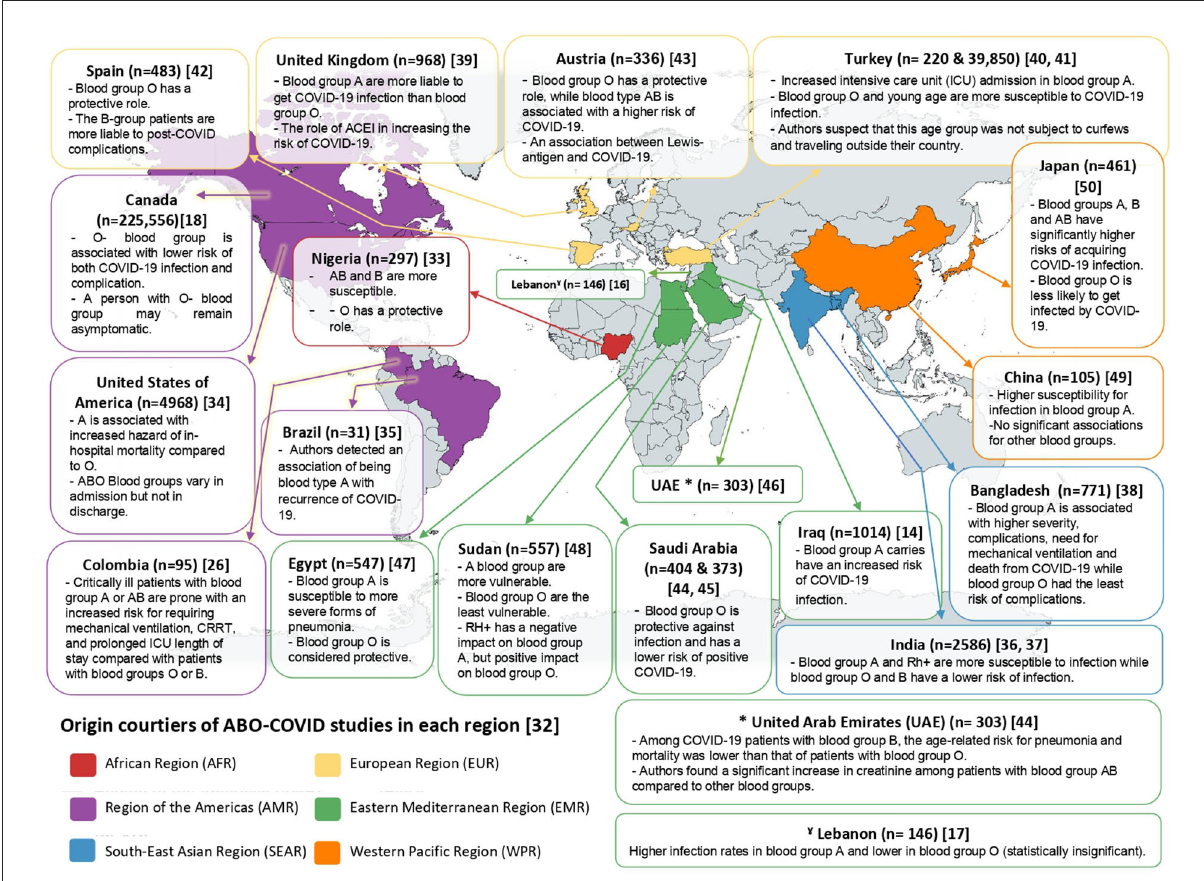
FIGURE2 Map clarifying the distribution of studies discussing ABO-COVID relationship from each region of WHO.